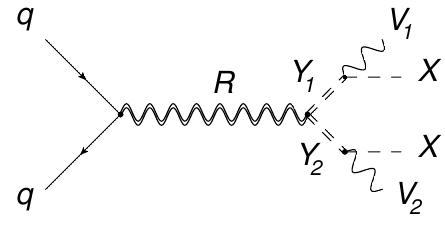
Figure 2 . Sample diagram for a R ! Y 1 Y 2 ! V 1 V 2 XX quadriboson